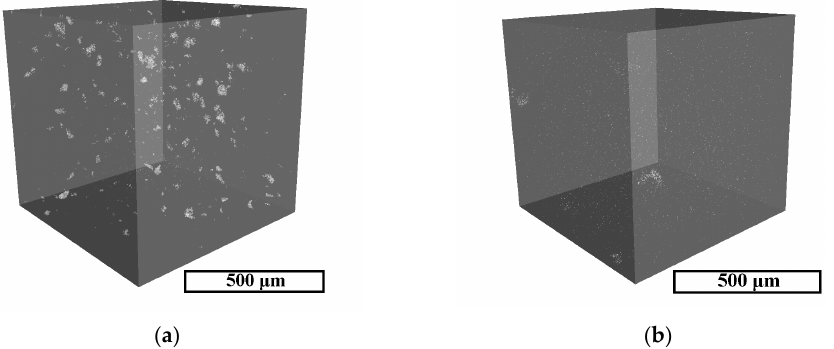
Figure 4. Images of xCT reconstructions of volumes with distribution of the TiC particles in SLM samples: ( a ) Inc 718 + micron-TiC, ( b ) Inc 718 + nano-TiC.